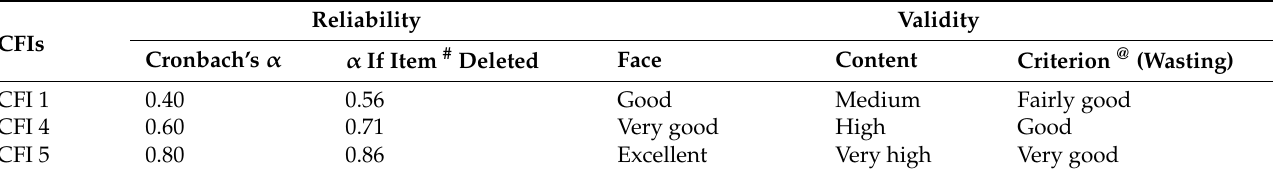
Table 6. Reliability and validity assessments of CCFIs.